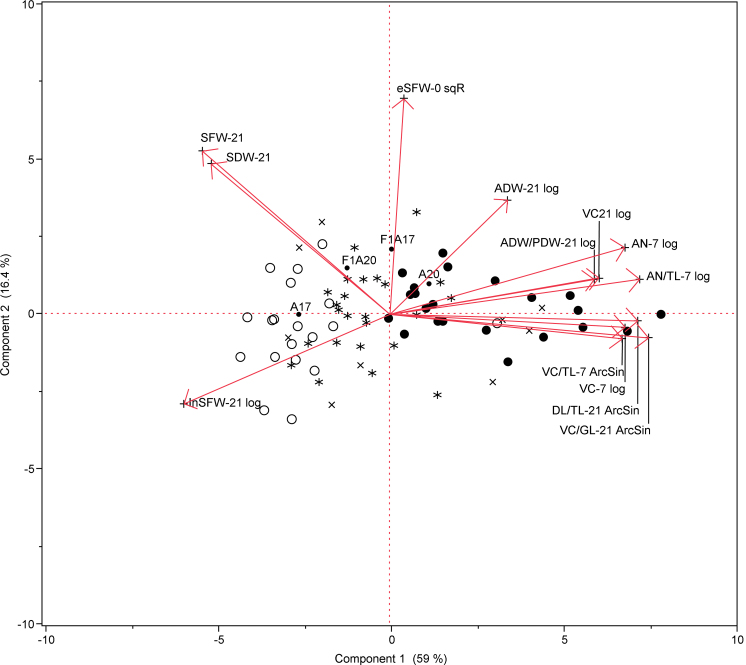
Principal component analysis biplot representing the overall response to SAA infestation in A17, A20, the F1 hybrids, and RILs derived from A17×A20 crosses. The arrows (loadings) represent the variables measured in response to SAA infestation (calculated from the line means); the arrow lengths represents the variance of the variable, and the angles between the arrows represents the correlation between the variables. The scores represent the line means. The scores for parental lines and F1 hybrids are shown by a tagged dot; the RIL scores are labelled according to their genotype at the h2_151m16a (LG3) and h2_2p16d (LG) loci, respectively: AAAA (cross), AABB (open circle), BBAA (closed circle), BBBB (star). RILs heterozygous at either of the loci were not included in the graph. (This figure is available in colour at JXB online.)